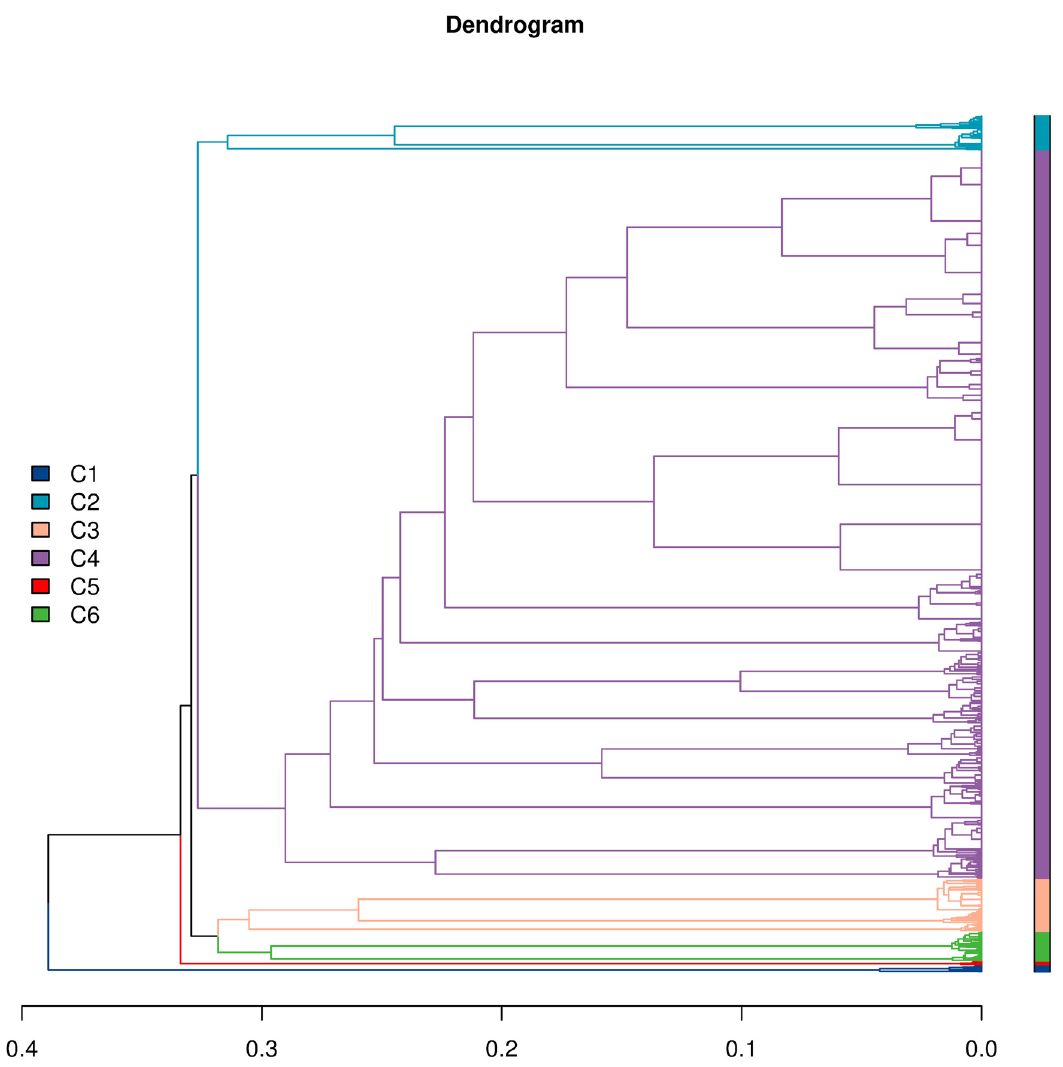
Fig 3. Dendrogram for group 1. Different clusters are represented with different colors. We cut the dendrogram at K = 6 because for larger values the obtained clusters were sub-partitions of already small clusters or subsequent sub-partitions of cluster C 4 into pairs of clusters one of which was really small and these additional partitions didn’t add to the interpretation of the input data.